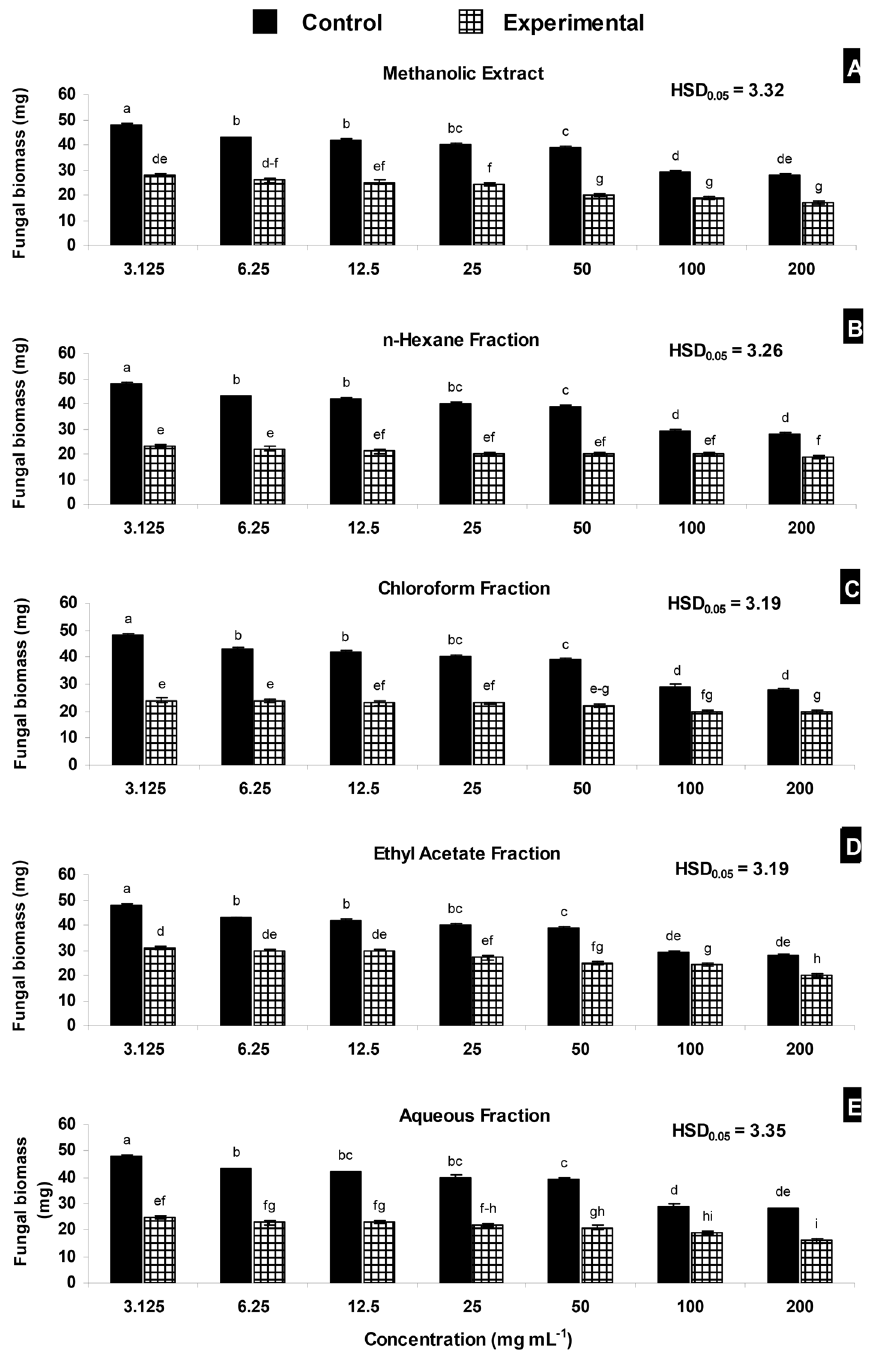
Figure 1. (A–E) Effect of methanolic extract of Monotheca buxifolia and its fractions on biomass of Macrophomina phaseolina . Vertical bars show standard errors of means of three replicates. Values with different letters at their top show significant difference (P ≤ 0.05) as determined by Tukey’s HSD